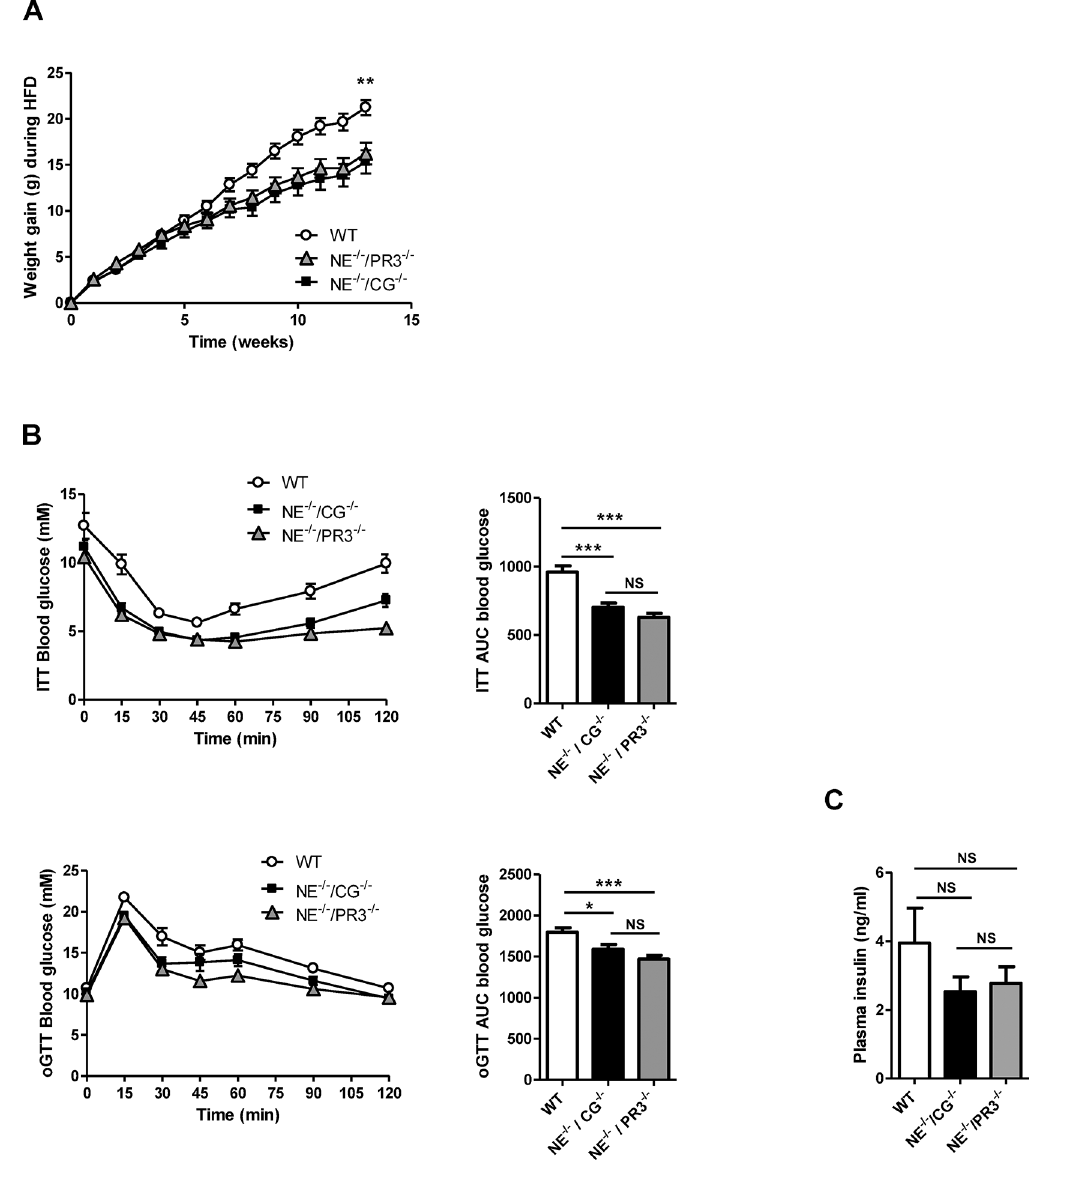
Figure 3. Improved NAFLD status and metabolic profiles in NE –/– /CG –/– and NE –/– /PR3 –/– mice after a high-fat diet. (A) Bodyweight develop- ment of wild-type ( n = 10), NE –/– /CG –/– ( n = 15) and NE –/– /PR3 –/– ( n = 15) mice during diet intervention. (B) Insulin tolerance test and ITT AUC values, oral glucose tolerance test and oGTT AUC values of wild-type, NE –/– /CG –/– and NE –/– /PR3 –/– . (C) Plasma insulin levels. (D) HE staining of liver sections. (E) Percentage of lipid droplets in HE-stained liver sections, liver weights and liver triglycerides levels. (F) Relative mRNA ex- pression of Cd36 , Fabp1 , Dgat1 , Fas , Ppar α and Cpt1a in liver. HFD, high-fat diet; WT, wild-type; ITT, insulin tolerance test; oGTT, oral glucose tolerance test; TG, triglycerides; *significant difference p ≤ 0.05; **significant difference p ≤ 0.01; ***significant difference p ≤